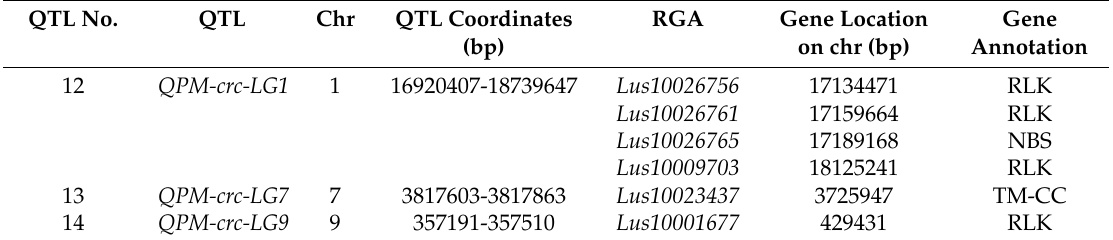
Table 4. Resistant gene analog (RGA) candidates near three QTL for flax powdery mildew resistance. QTL No.